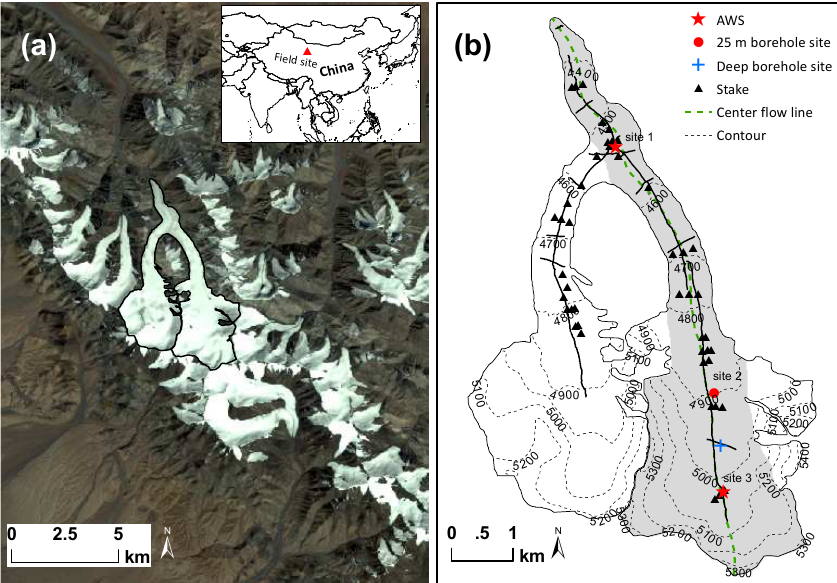
Figure 1. (a) The location of Laohugou Glacier No. 12 (LHG12) on western Qilian Shan, China. Underlain is a Landsat 5 TM image acquired on 22 September 2011. (b) The solid and thick black lines indicate the ground-penetrating radar (GPR) survey lines. The shaded area denotes the main branch of LHG12, which neglects the west branch and all small tributaries. The green dashed line represents the centre flow line (CL). Red stars indicate the locations of the automatic weather stations (AWSs) and the 25m deep shallow boreholes (sites 1 and 3). A solid red circle represents the location of the shallow borehole at site 2, and a blue cross represents the location of the deep ice borehole. Black triangles show the positions of the stakes used for ice surface velocity measurements. The black contours are generated from SRTM DEM in